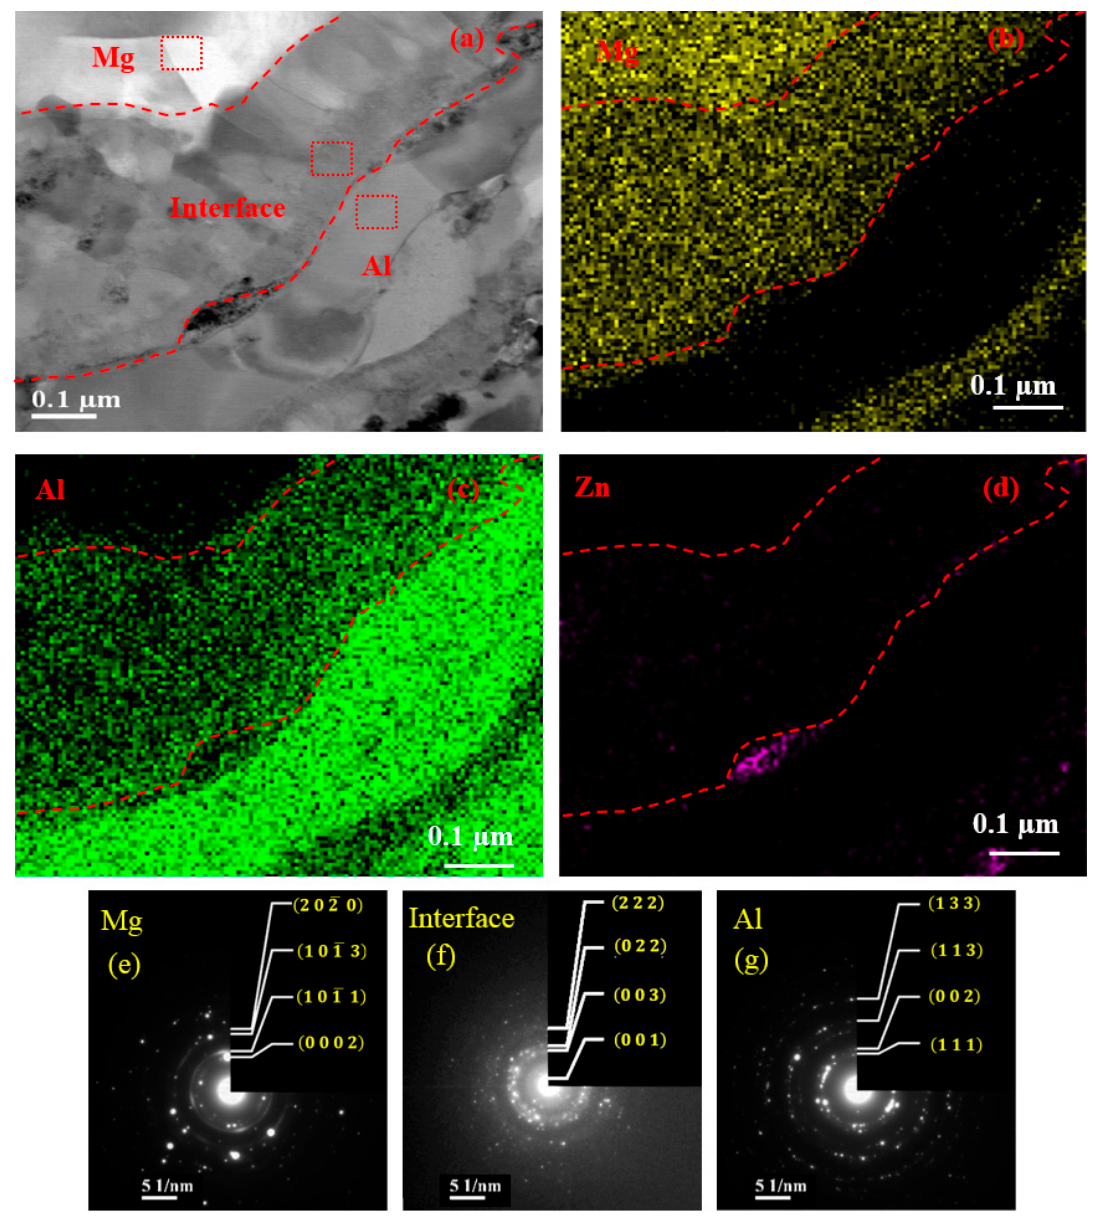
Figure 2. Typical bright field-transmission electron microscope (BF-TEM) microstructure ( a ) near the interface along with the EDX image mapping ( b – d ) and the SAED pattern ( e – g ) of the corresponding zones, separated by the red dashed lines.